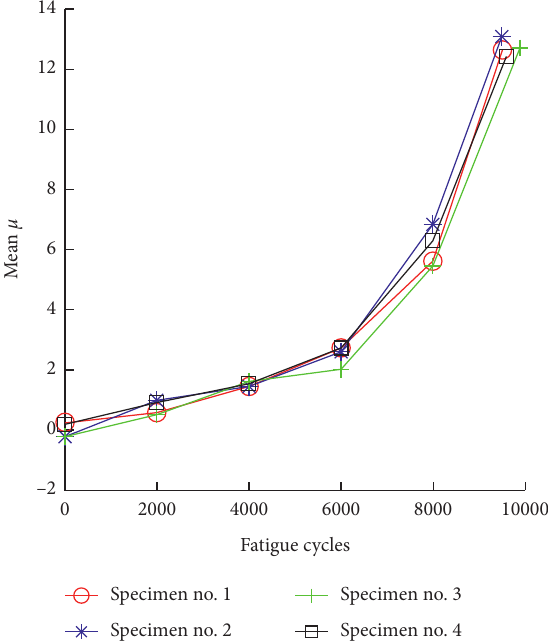
Figure 13: The variation curves of mean value μ.